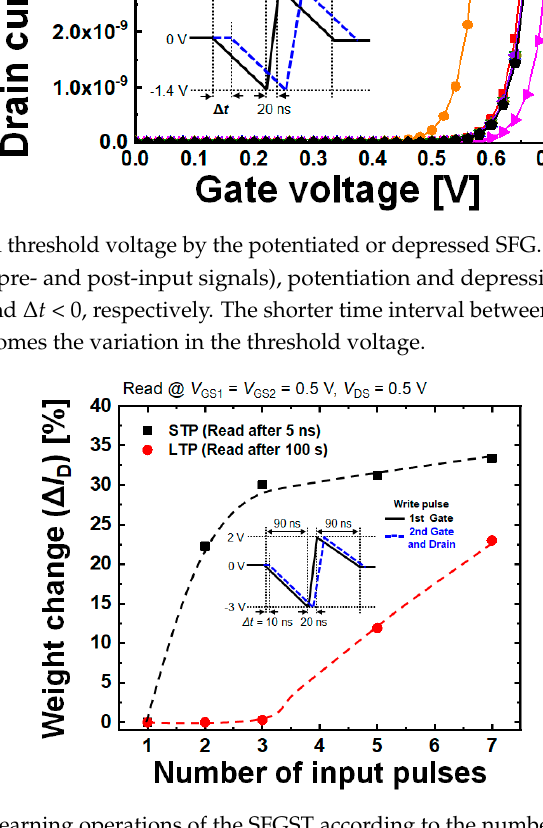
Figure 11. Simulated learning operations of the SFGST according to the number of potentiation pulses.